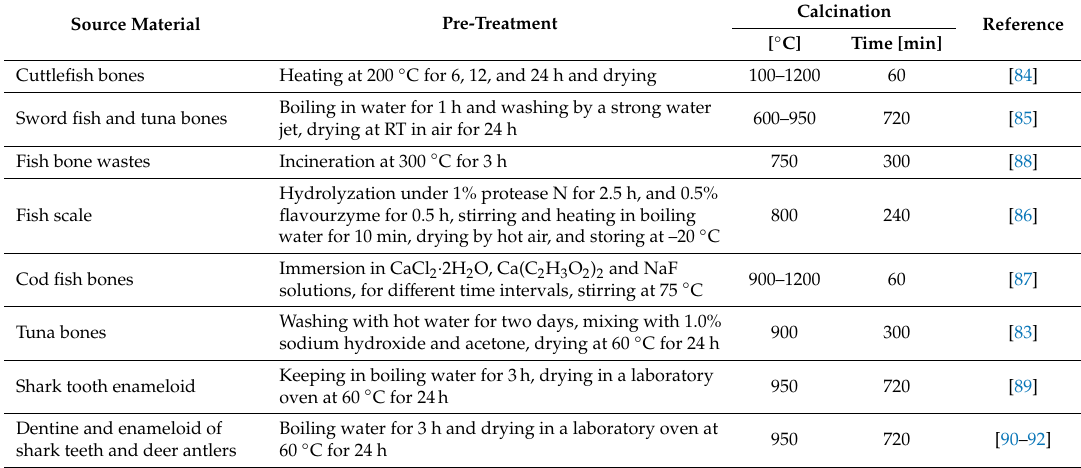
Preparation of HA powders derived from fish sources, presented in order of the calcination